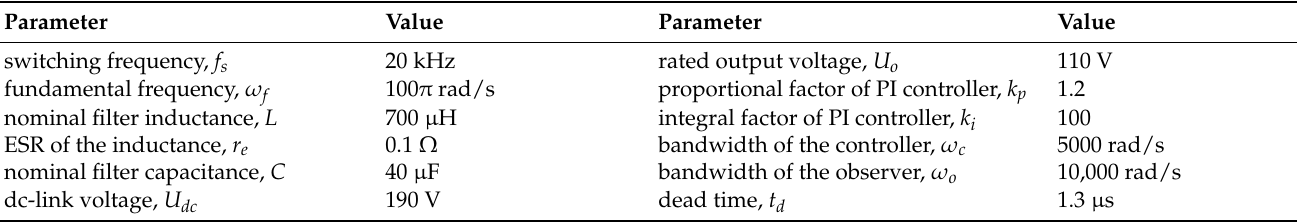
Table 3. Parameters of the inverter system.